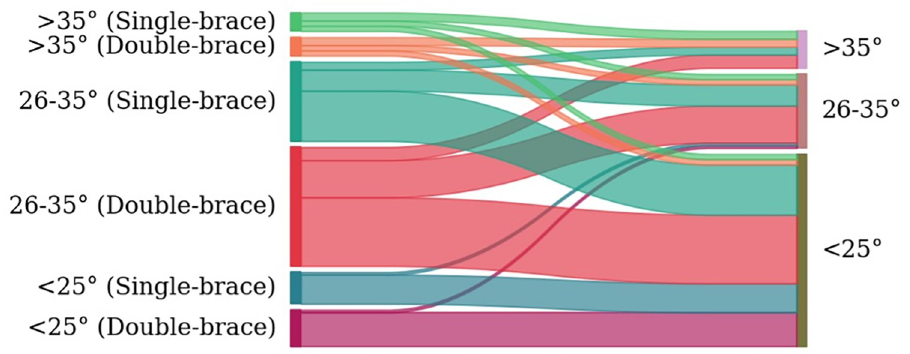
Fig 6. Distribution of treatment results in both treatment groups (red color schemes for double-brace group, green-color schemes for single-brace group) sorted categorial by primary initial COBB-angle value (left axis) and finale COBB-angle 2 years after brace weaning (right axis).